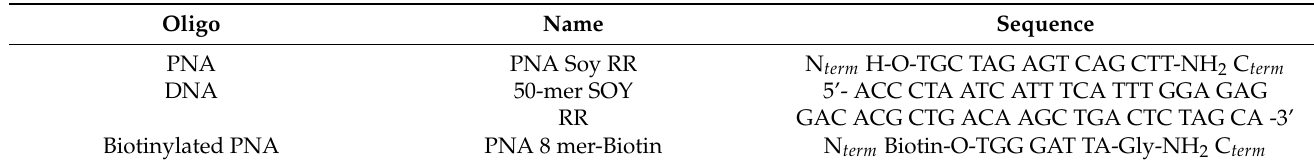
Table 1. Different summarized Oligo chemicals used in the chemical infiltration